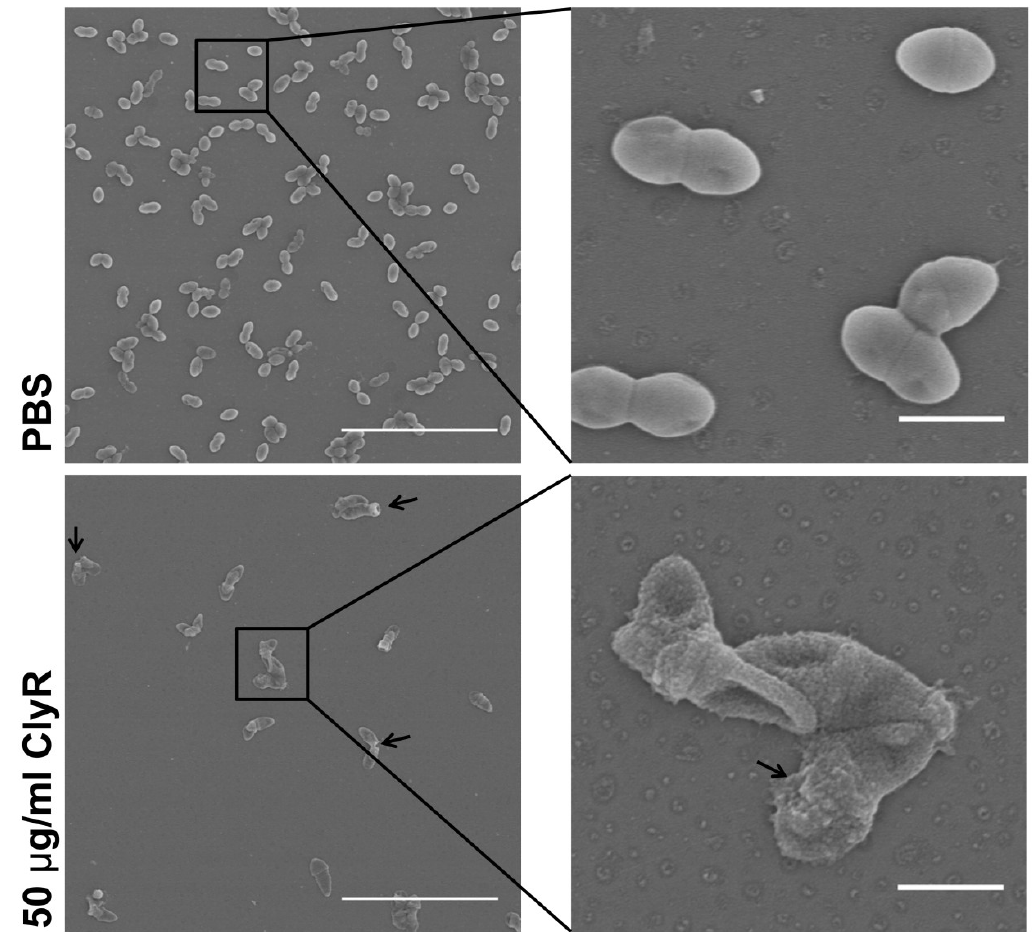
Figure 4. SEM analysis of E. faecalis biofilms after exposure to ClyR. E. faecalis ATCC 51299 is cultured in BHIG on glass coverslips for 24 h to allow biofilms, after washing with PBS, biofilms are treated with 50 μg/mL ClyR for 1 h at 37 °C, the residual biofilms are sampled and analyzed by SEM. PBS treated groups are used as controls. Scale bars: left panel: 10 μm; right panel: 1 μm.